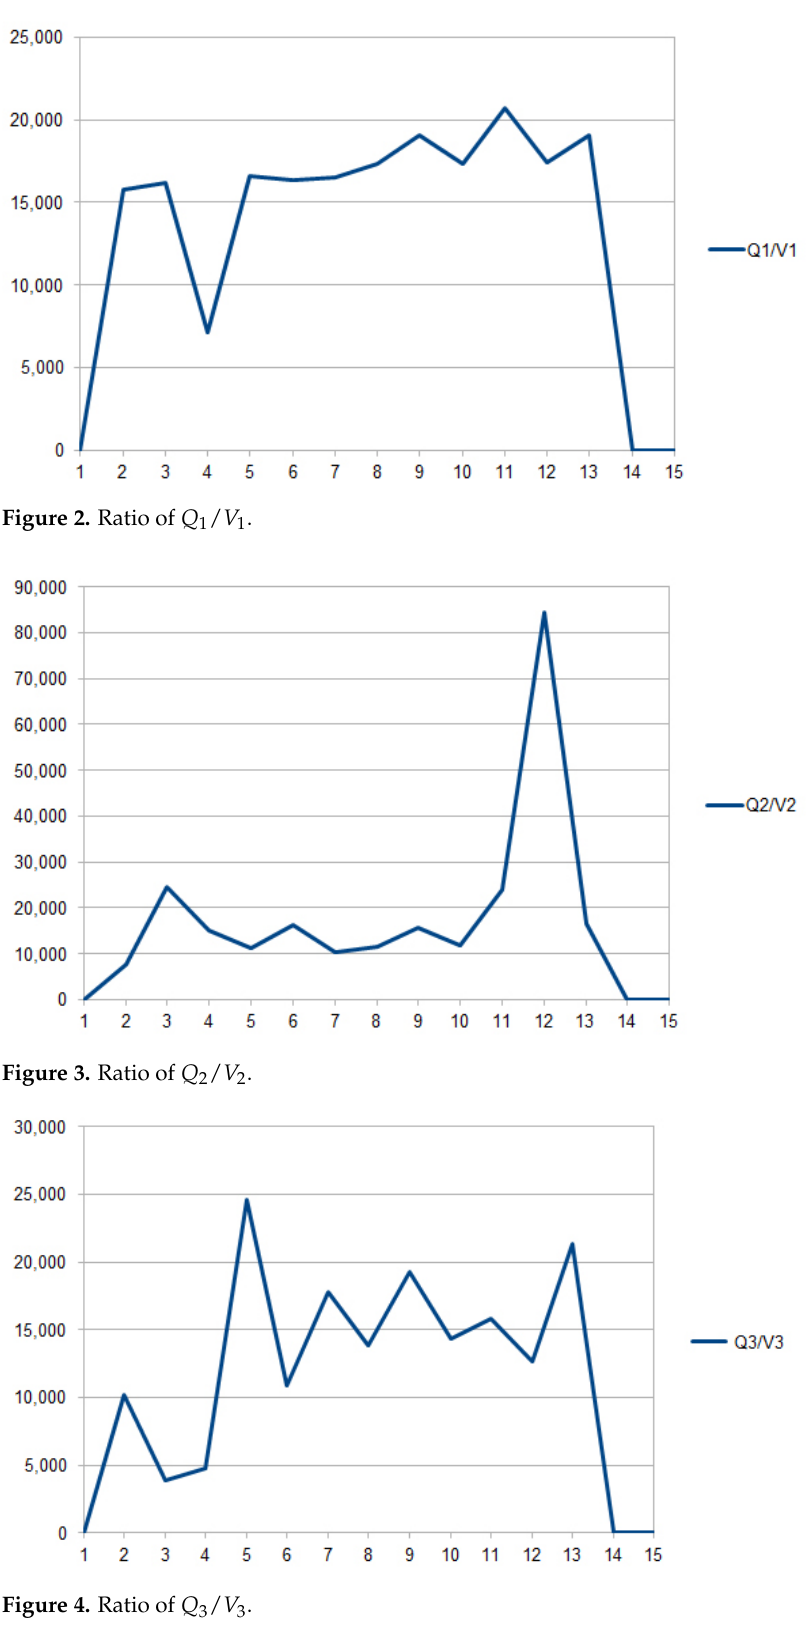
Figure 4. Ratio of Q 3 / V 3